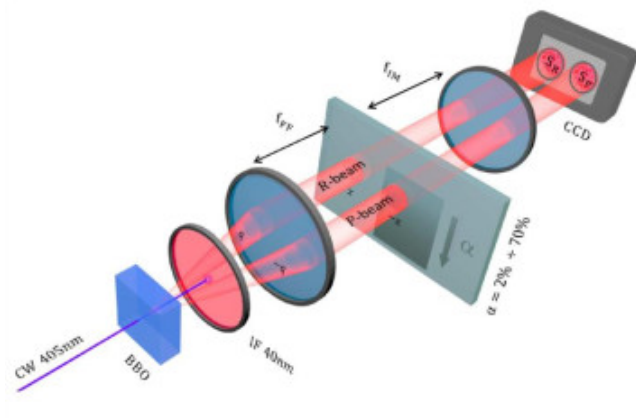
Figure 1. Experimental set-up used to demonstrate quantum enhancement in absorption